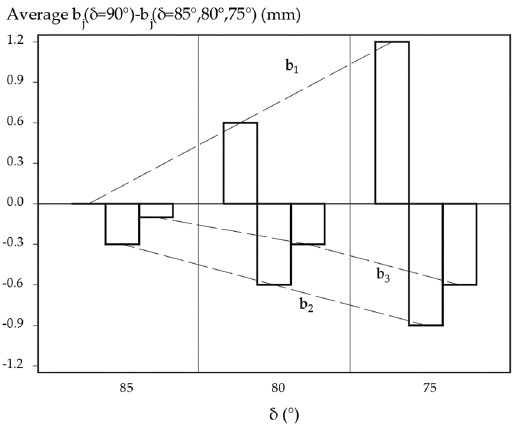
Figure 13. The average difference between b 1 , b 2 , and b 3 for δ = 90 ◦ and b 1 , b 2 , and b 3 for δ = 85 ◦ , 80 ◦ , and 75 ◦ .